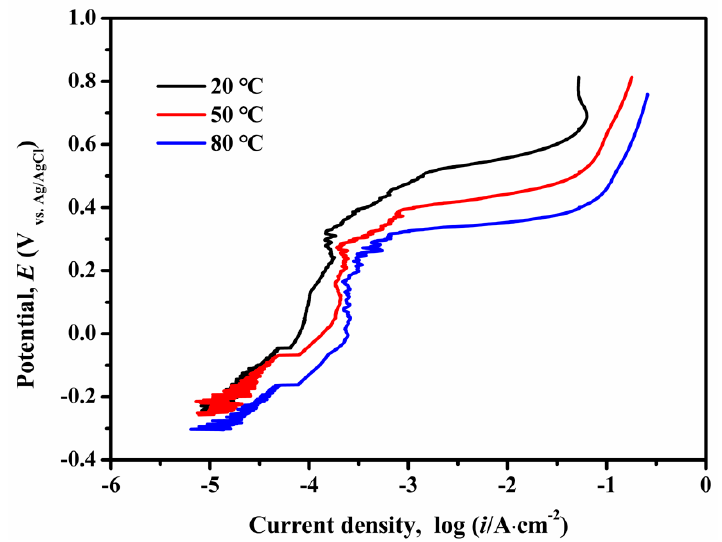
Figure 1. Anodic polarization curves of the CMSX-4 superalloy obtained at 20 °C, 50 °C, and 80 °C in 3.5 wt.% NaCl solution.